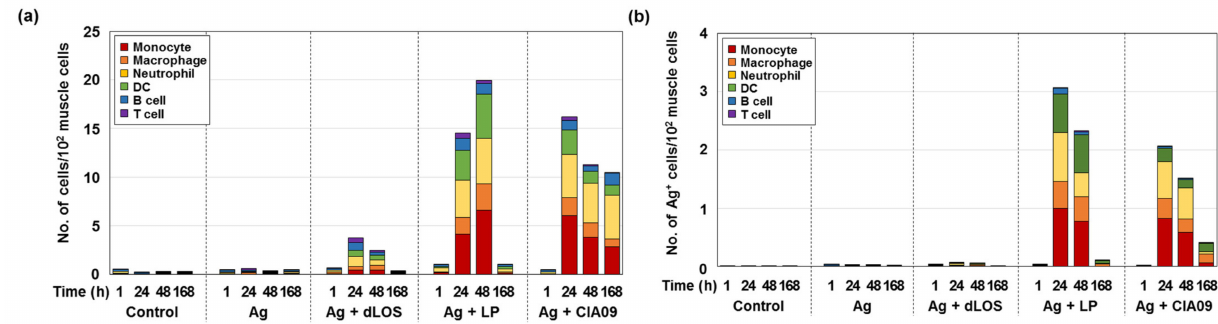
Figure 8. Antigen uptake at the SOI. Groups of mice ( n = 3) were given an intramuscular injection with AF647-labeled gE (5 µ g), alone or in combination with dLOS (2 µ g), liposomes (LP) (100 µ g), or CIA09, and muscle samples were collected at 1, 24, 48, and 168 h post-injection. Single cells were prepared, stained with antibodies specific for immune cell markers, and analyzed by flow cytometry. ( a ) Immune cell populations at SOI; ( b ) the frequency of antigen-positive immune cells. The results are expressed as the mean of values obtained from three muscle samples for each group. The data shown are representative of three independent experiments with similar